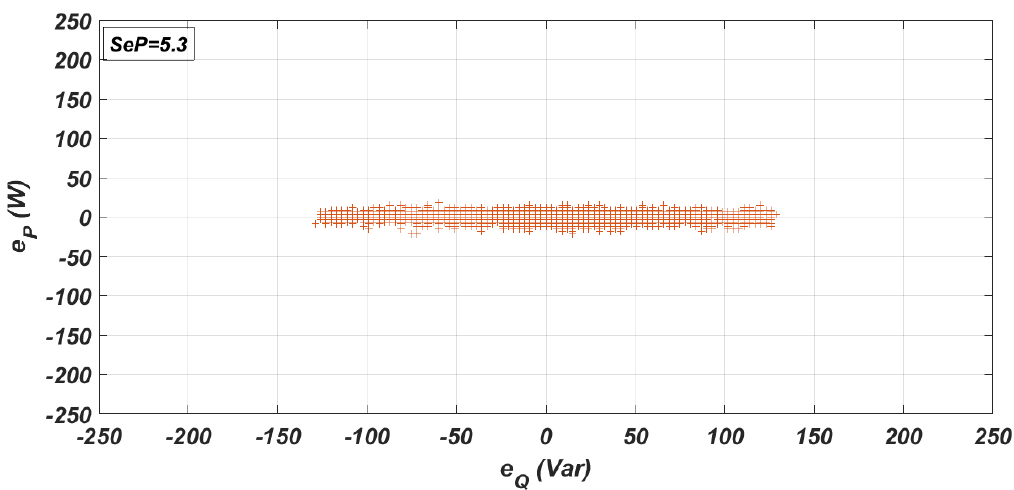
Figure 9. Plot of [ e P ( t ), e Q ( t )] pairs used for the calculation of SeQ for droop control.